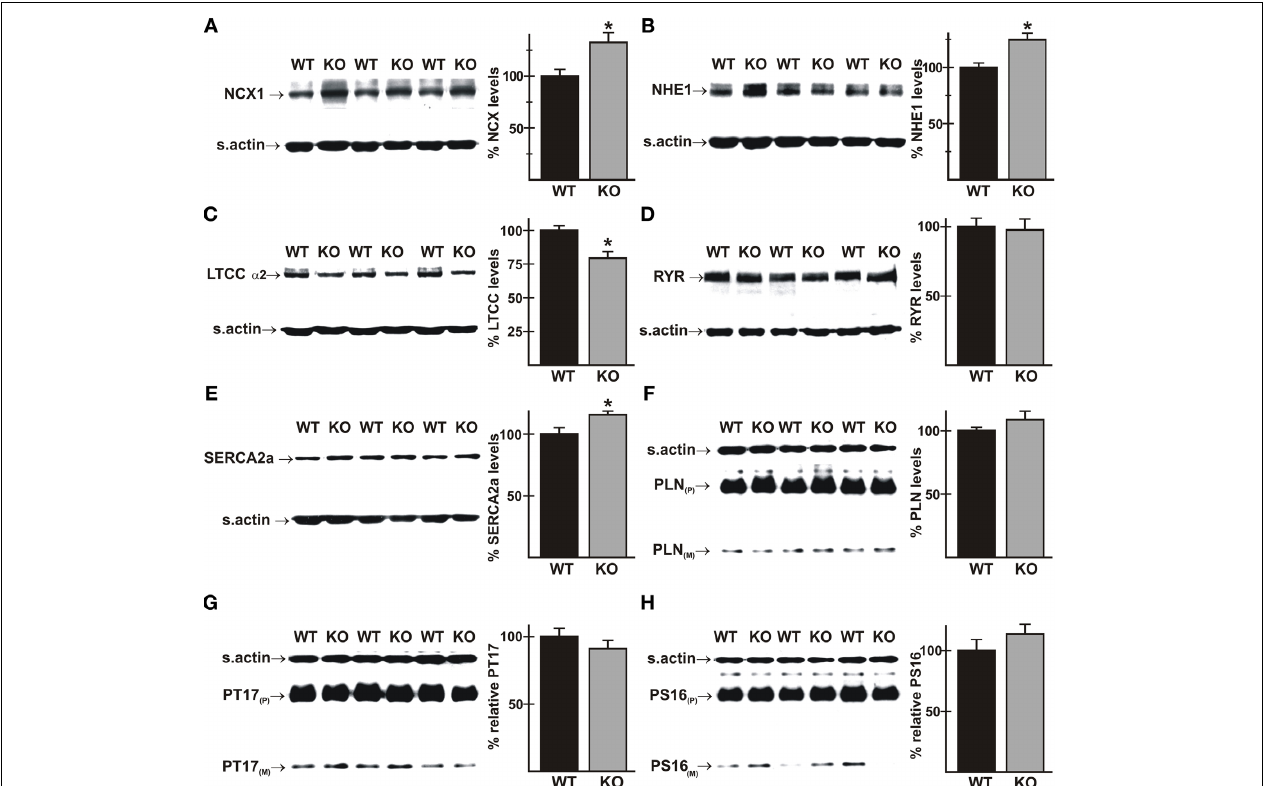
FIGURE 3 | Expression of proteins that affect Ca 2 + -handling in wild-type and AE3-null hearts. Proteins from total homogenates of WT and AE3-null (KO) hearts were subjected to immunoblot and densitometric analyses; levels of each protein were normalized to levels of sarcomeric actin (s.actin) in the same sample. Results show representative immunoblots, with sarcomeric actin controls, and percent expression levels of: (A) NCX1 Na + /Ca 2 +